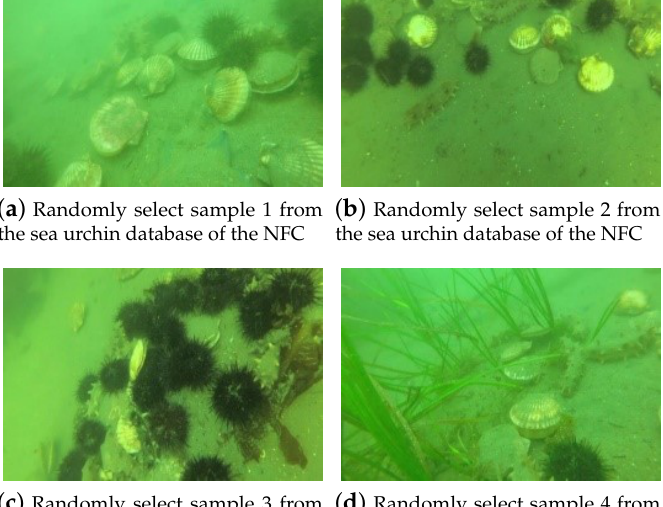
Figure 7. Underwater test images.